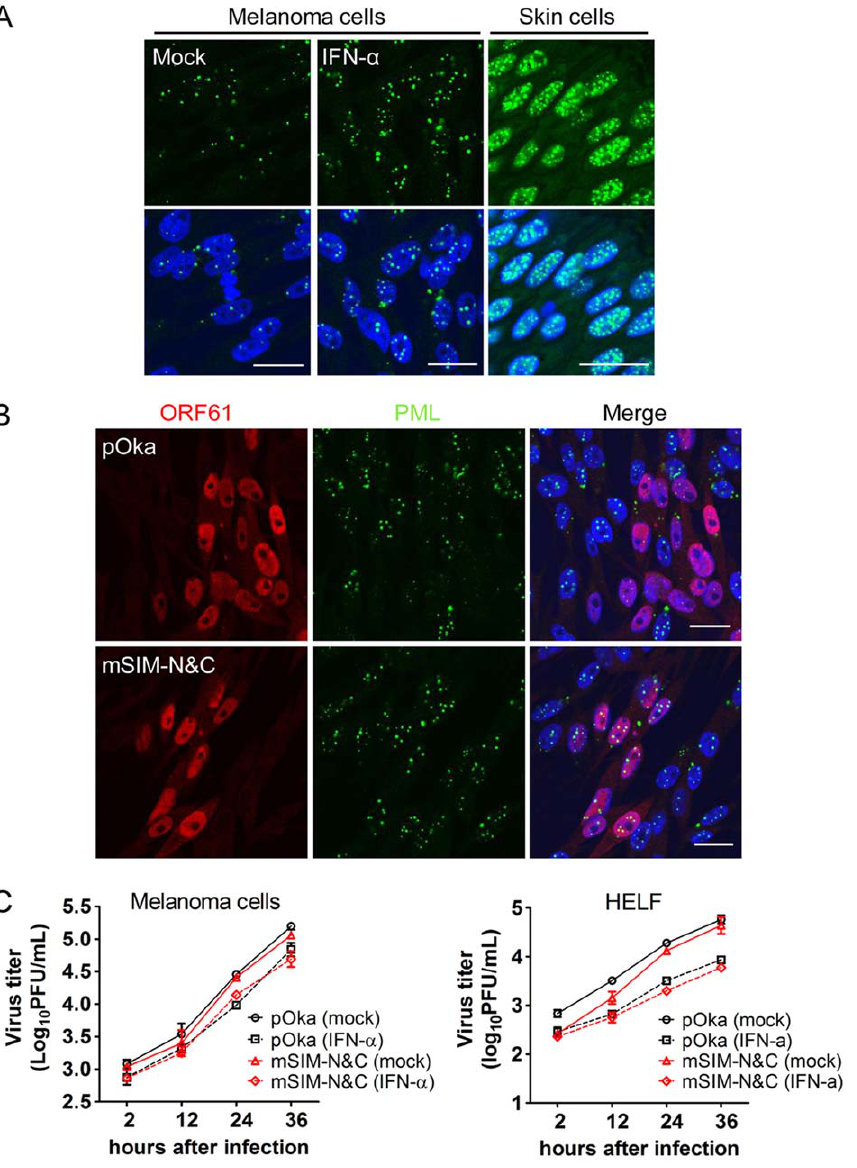
Figure 8. ORF61 SIM-dependent disruption of PML NBs is not required for VZV replication in cultured cells treated with IFN- a . (A) Confocal microscopy of mock- or IFN- a -treated melanoma cells that were stained for PML (green) and nuclei (blue) (left and middle panels). Right panel shows PML NBs (green) in uninfected cells from pOka-infected skin xenografts. Nuclei were stained with Hoechst (blue). Scale bars: 20 m m. (B) Confocal microscopy of melanoma cells that were treated with IFN- a and then infected with pOka or pOka-mSIM-N&C. Cells were stained for ORF61 (red), PML (green), and nuclei (blue). The images show PML NBs in cells expressing abundant ORF61 and SIM mutant proteins. Scale bars: 20 m m. (C) Replication of pOka and pOka-mSIM-N&C in melanoma cells (left panel) and HELF cells (right panel) treated with IFN- a . Each point represents mean 6 SEM of virus titers from three replicates. doi:10.1371/journal.ppat.1002157.g008 region and proline may interrupt the b -strand conformation required for the interaction. Our analysis of ORF61 SIM-C